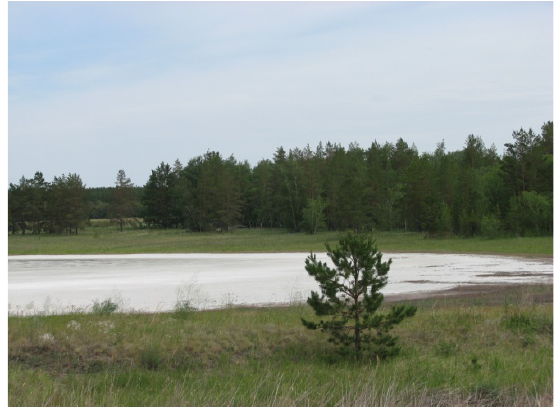
Figure 1B. The unusual ecosystem of Northern Kazakhstan. In Northern Kazakhstan (Kustanai region), samples were collected from the soils of the steppe and forest zones, sor solonchaks (non-perennial salts lakes in the area of Aman-Karagai forest), solods, solonets soils (steppe and meadow), rhizospheres of plants from halophytic meadows, and muds from the salt lakes.